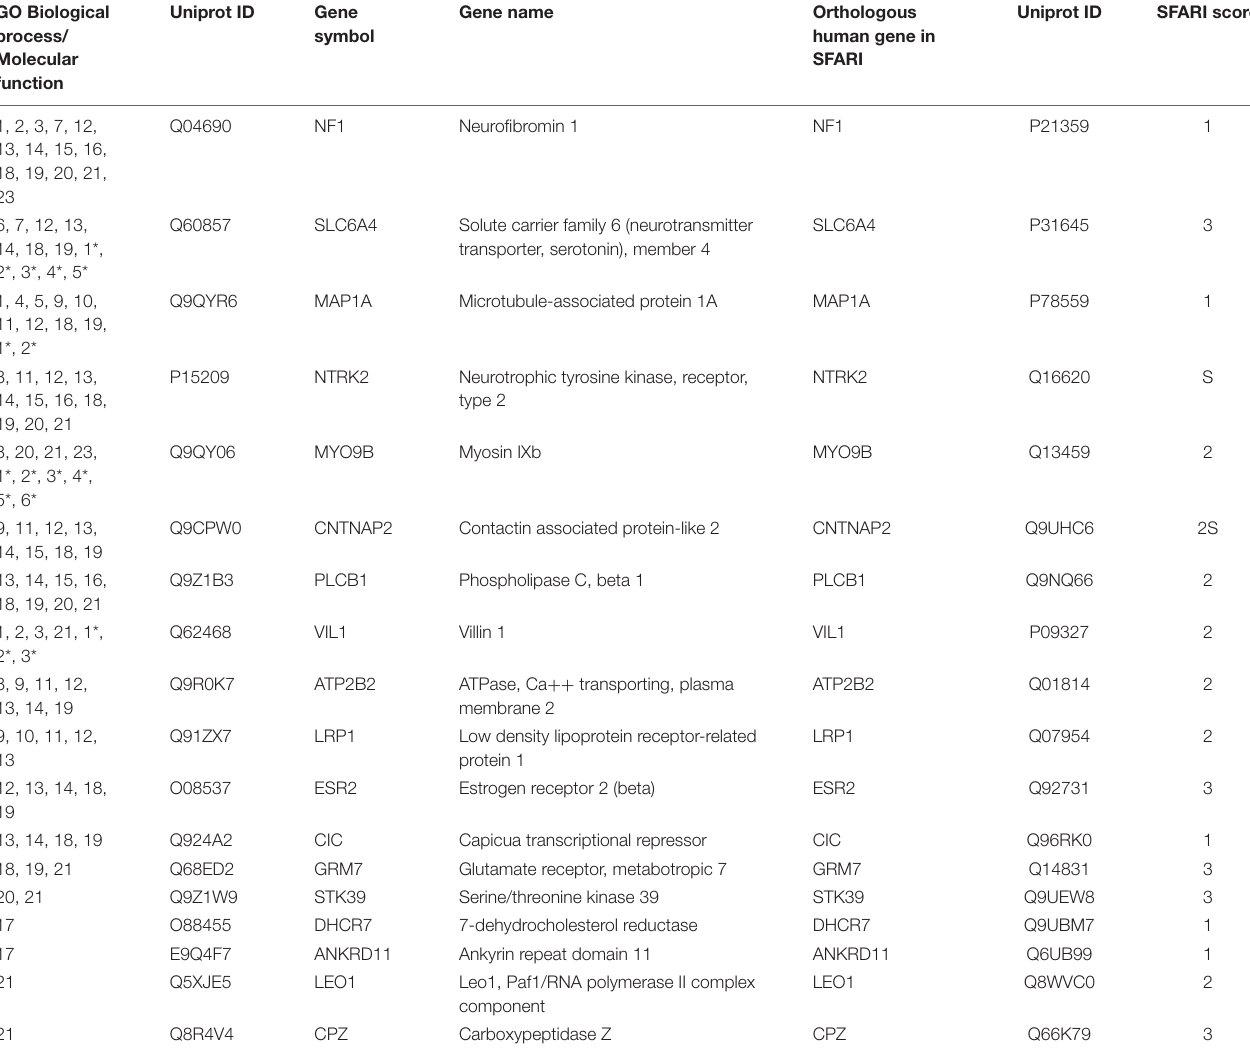
Uniprot ID SFARI human gene in SFARI